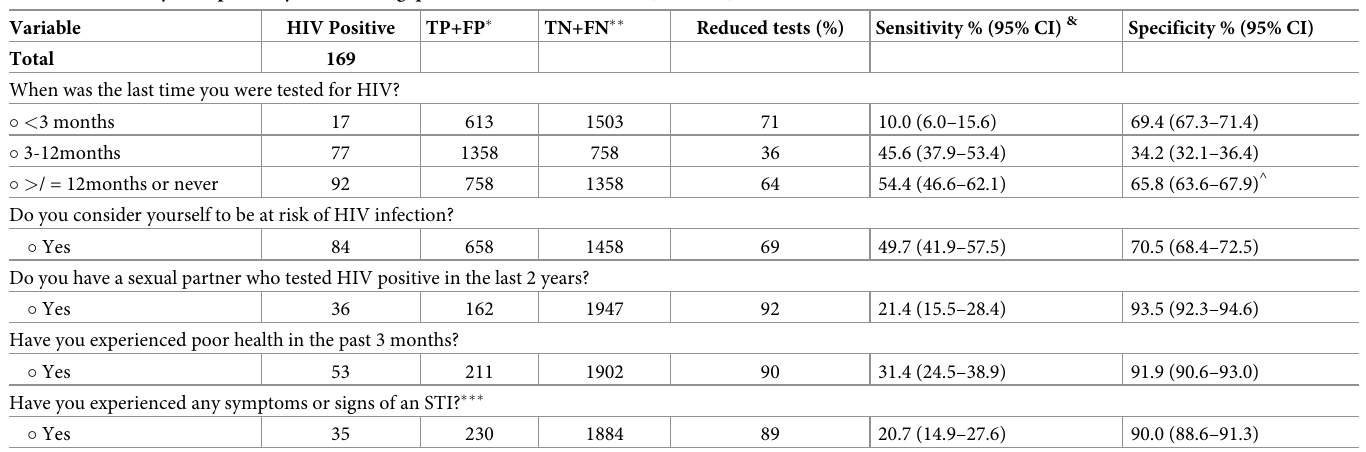
Table 4. Sensitivity and specificity for screening questions, Zimbabwe, 2021. (N = 2116) # .